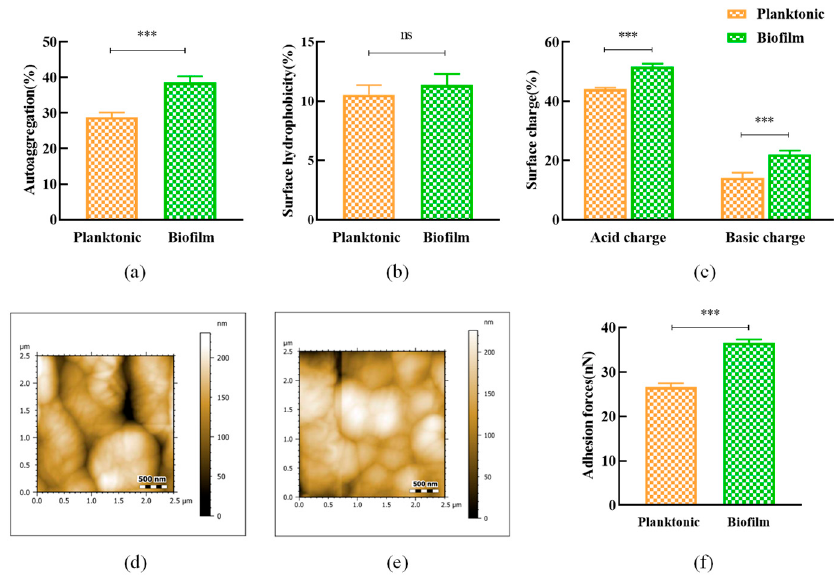
Figure 3. Cell surface properties. Automatic aggregation capability ( a ), hydrophobicity ( b ) and surface charges ( c ) of L. plantarum Y42 in the planktonic and biofilm forms. AFM images of L. plantarum Y42 in the planktonic ( d ) and biofilm ( e ) forms. Adhesion force on the surface of L. plantarum Y42 in the planktonic and biofilm forms ( f ). * p < 0.05; *** p < 0.001; ns is not significant.